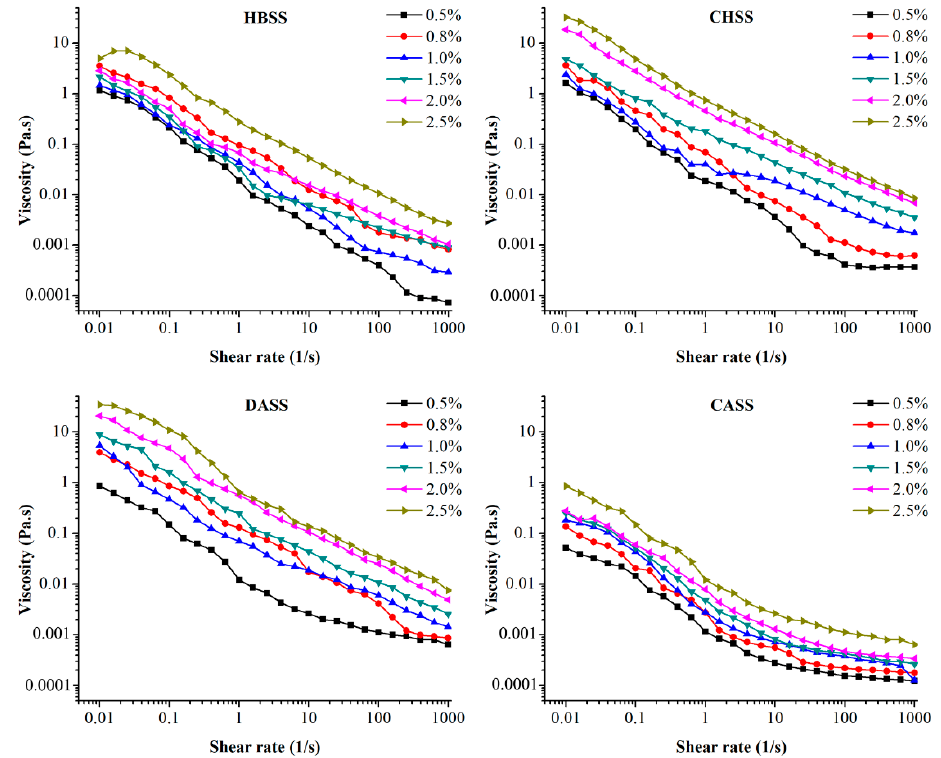
Figure 2. Variation of apparent viscosity of MLPs at different concentrations with rising shear rate at 20 °C. Table 1. Exponent n and coe ffi cient m of η = m × γ × n − 1 as a function of concentration for MLPs in water at 20 ◦